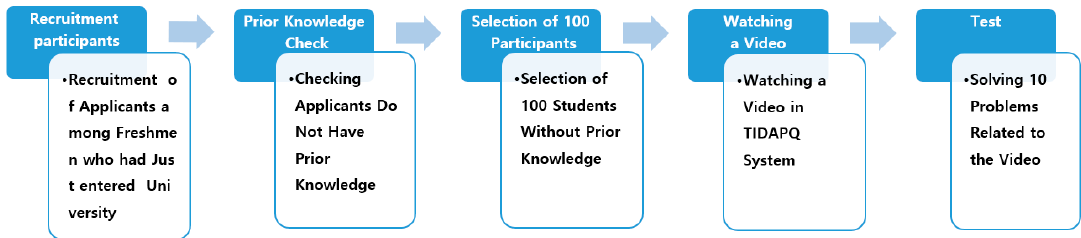
Figure 8. Model verification experimental design.